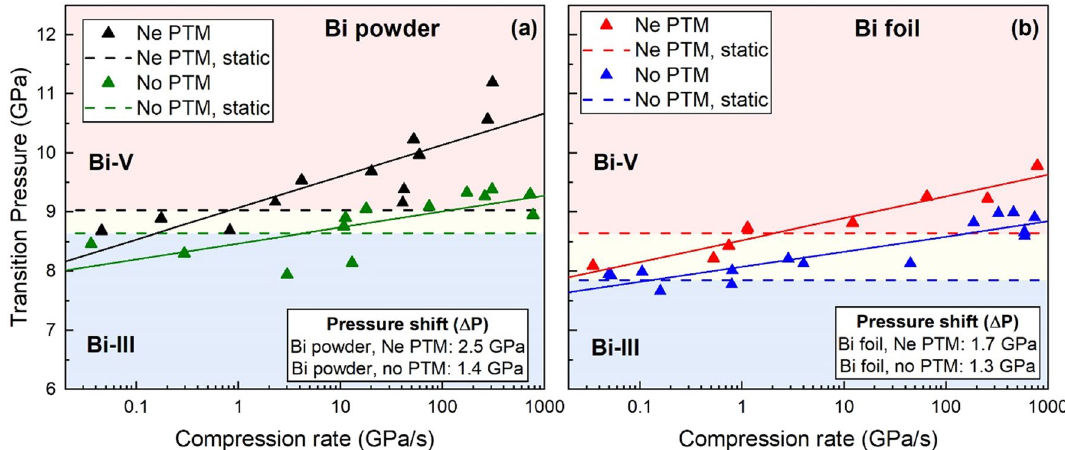
Figure 4. Bi-III/Bi-V transition pressure as a function of compression rate for different sample types (foil and powder) and different sample conditions (with and without a PTM). The transition is identified by the first appearance of Bi-V in the diffraction patterns, as described in the text. The solid lines show a fit of the dynamic compression data to functional form y = Alog ( x ) + B , and the resultant fit parameters are given in Table